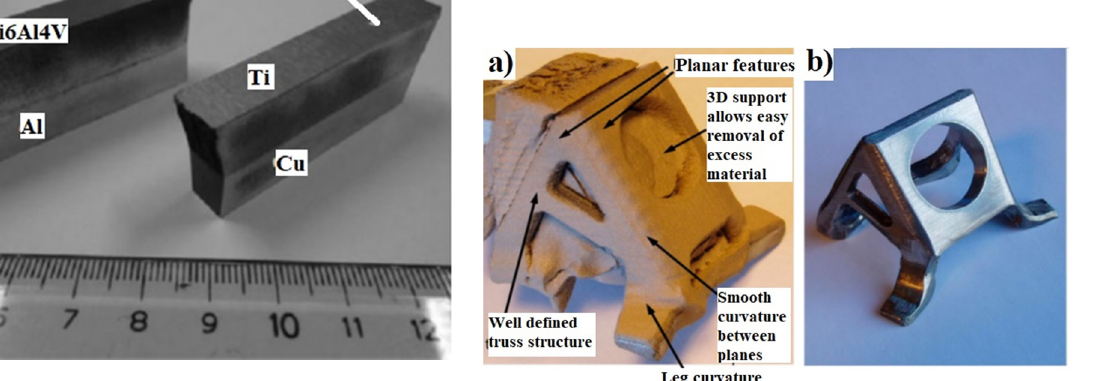
Figure 13: CS interpreted concept: ( a ) mandrel after deposition and ( b ) mandrel removed and post - machined [ 55 ]